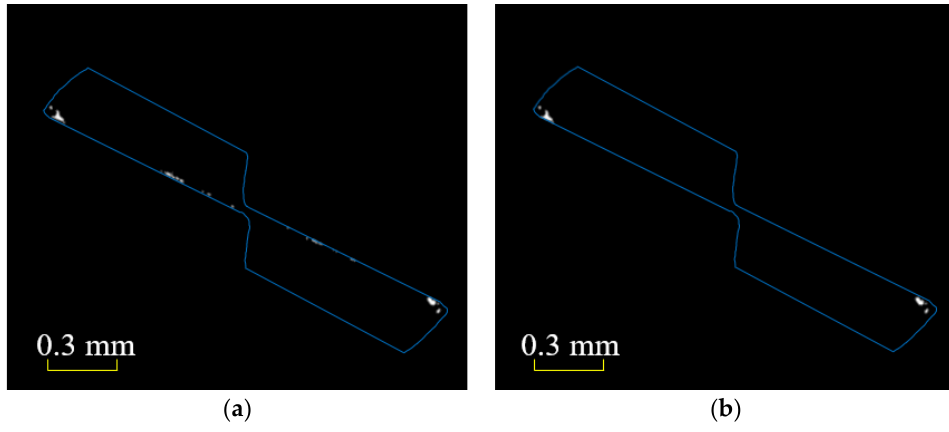
Figure 6. Adaptive region localization. ( a ) Adaptive preliminary region localization; ( b ) Final region localization of the abrasion.